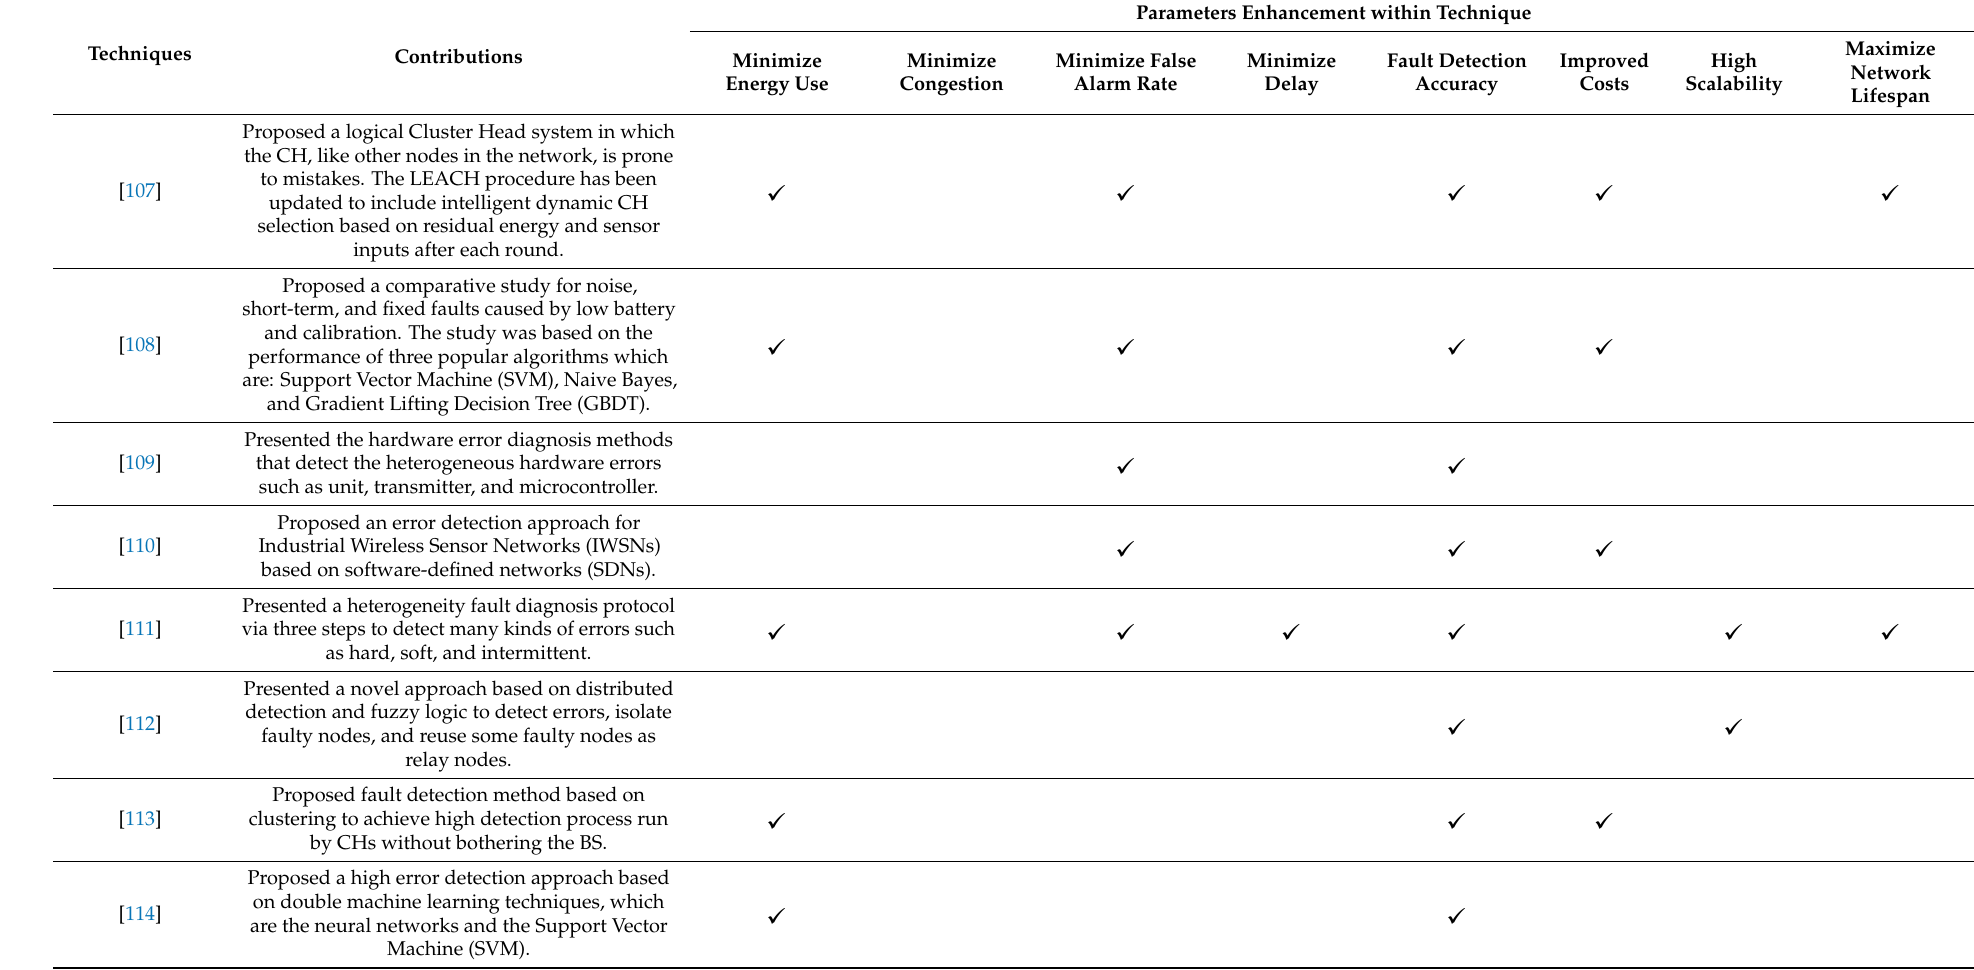
Table A1. Cont. Table 1. Surveys on Fault-Tolerant in WSNs. Table 1. Surveys on Fault-Tolerant in WSNs. Table 1. Surveys on Fault-Tolerant in WSNs. Table 1. Surveys on Fault-Tolerant in WSNs. Table 1. Surveys on Fault-Tolerant in WSNs.